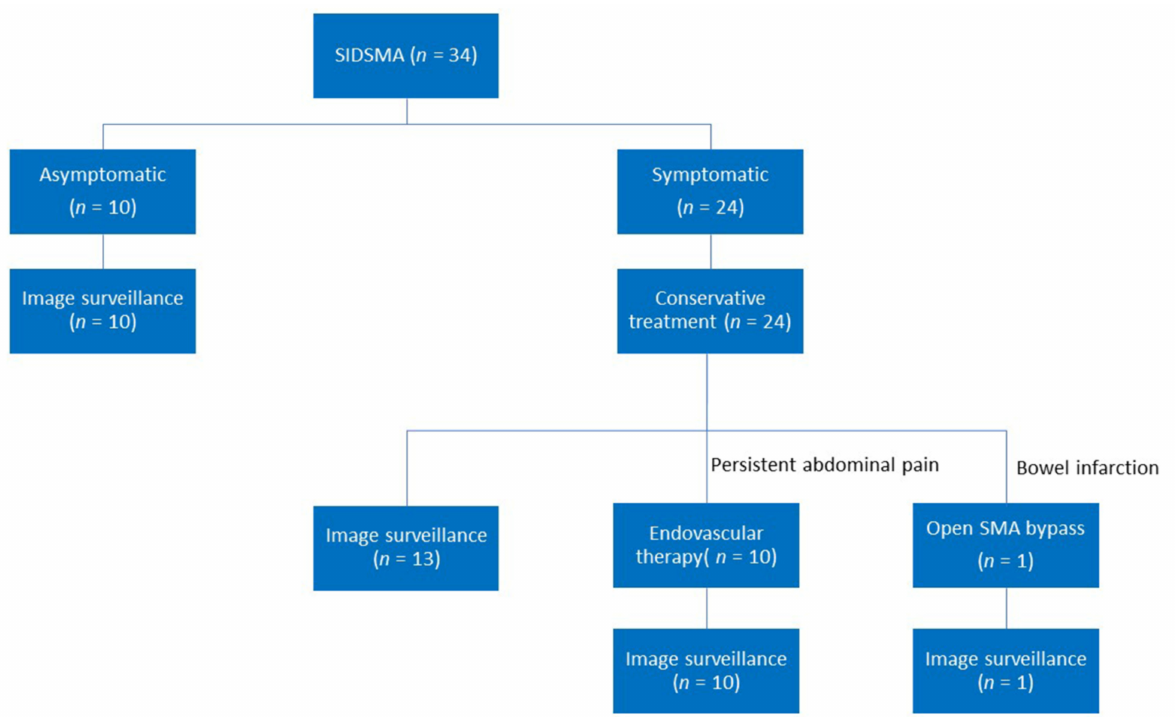
Figure 2. Patient treatment algorithm. SIDSMA: spontaneous isolated dissection of superior mesen- teric artery, SMA: superior mesenteric